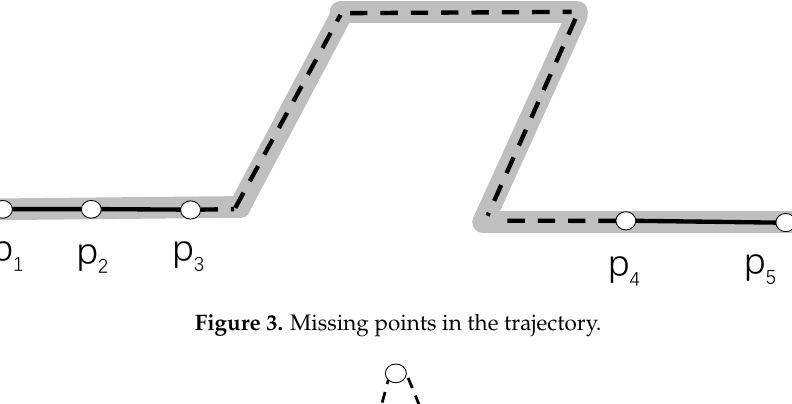
Figure 3. Missing points in the trajectory.